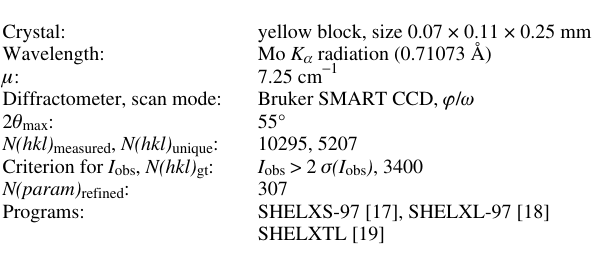
Table 1. Data collection and handling. Crystal: